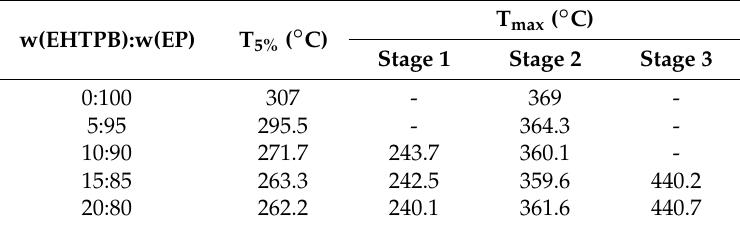
Table 2. Decomposition temperatures of the modified epoxy resin with different w(EHTPB)/w(EP) ratios.